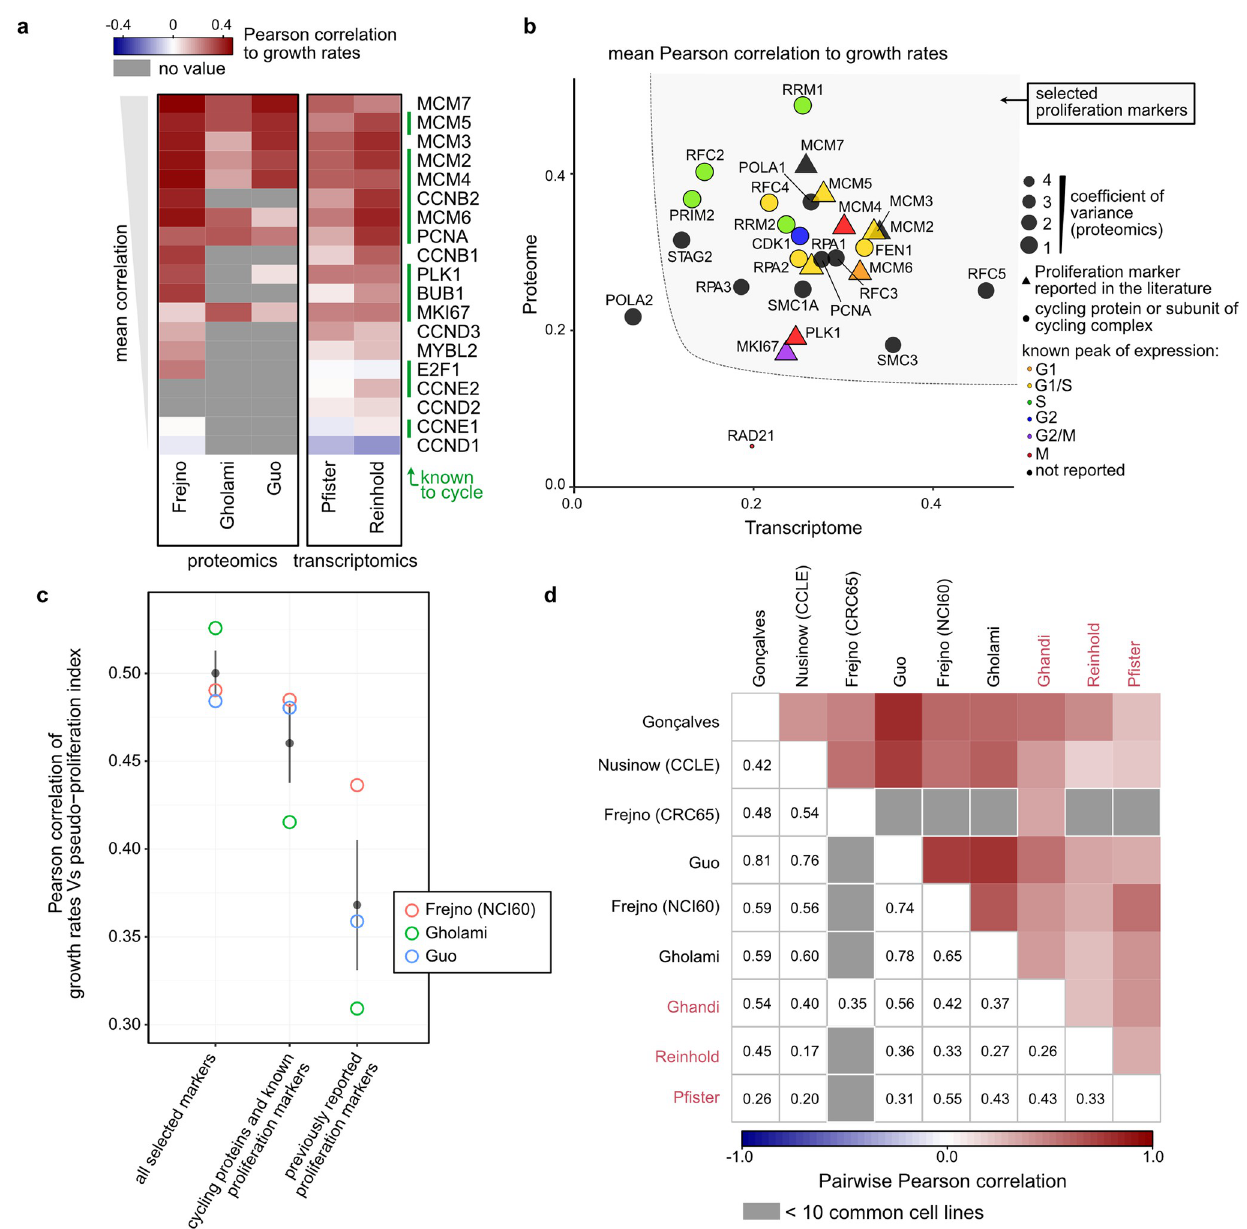
Fig 1. Calculation of pseudo-proliferation index. a) Pearson correlation with growth rates of the NCI60 cell lines that follow the Developmental Therapeutics Program (DTP)’s growing instructions for proliferation markers referenced in the literature. The proteins that cycle in Cyclebase 3.0 are indicated by green bars on the right (“known to cycle”), and the data set names are indicated in the bottom. b) Set of known markers, cycling genes and complex-associated subunits considered as proliferation marker for pseudo-proliferation index calculation. Mean Pearson correlation with growth rates in the datasets presented in (a) in the proteome (vertical axis) and transcriptome (horizontal axis). The point size is proportional to the inverse of the coefficient of variance in the proteomics data, proteins present in less than 2 data sets were excluded, as well as the cycling CDC27 due to its negative correlation with growth rates in the proteomics data sets. Periodic genes are color-coded by the phase of their expression peak, proliferation markers reported in the literature are indicated by triangles. The selected proliferation markers are indicated by the grey area. c) Pearson correlations between pseudo-proliferation index and growth rates in the proteomics data sets presented in (a) using the mean signal of the proliferation markers as selected in (b) (grey area), all the previously reported proliferation markers, or the previously reported proliferation markers and cycling genes with the exclusion of RAD21. Grey points and bars are mean and confidence intervals across data sets. d) Pairwise Pearson correlation between the pseudo-proliferation indexes calculated in the different data sets (proteomics and transcriptomics in black and red, respectively) Pairwise comparisons with less than 10 cell lines were excluded (in